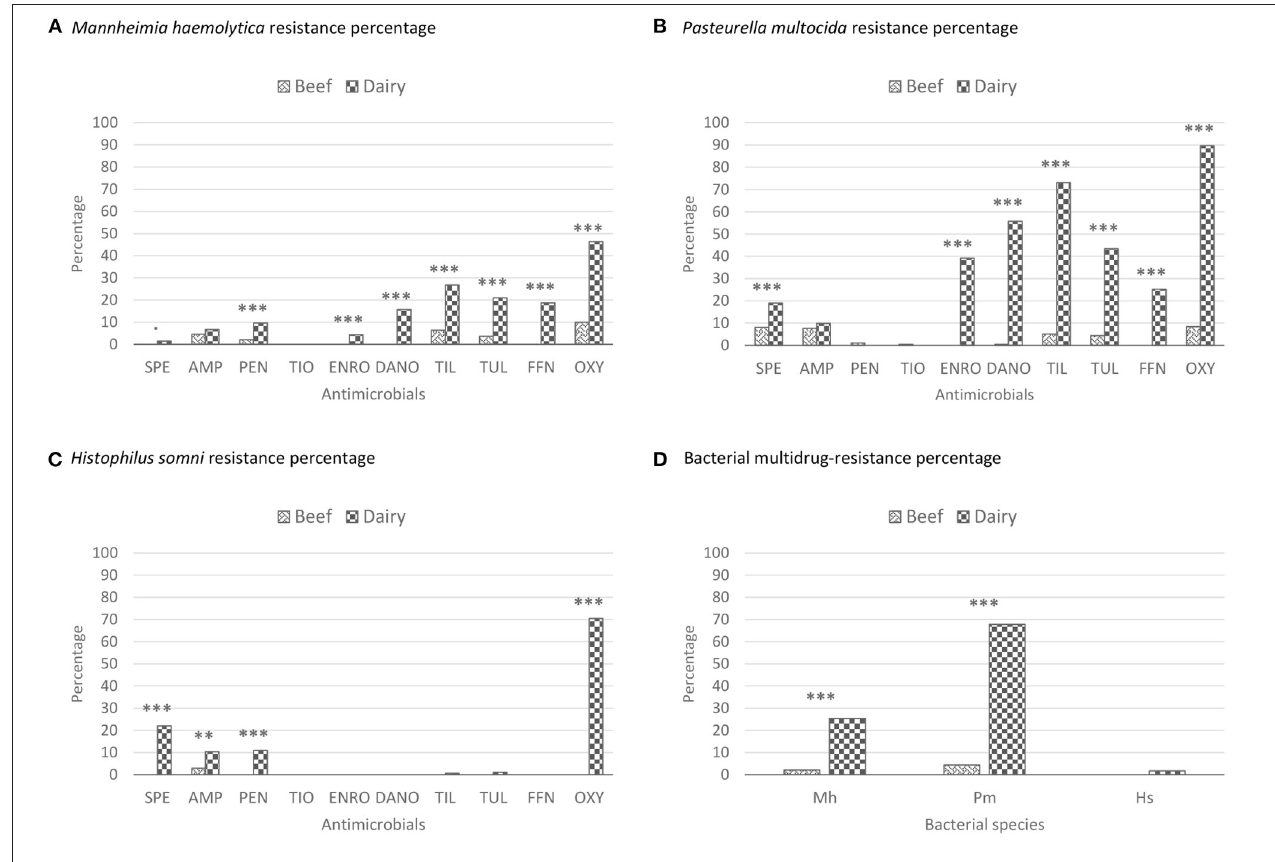
FIGURE 2 | Antimicrobial resistance percentages of the BRD-bacterial isolates recovered from beef and dairy-type cattle upon feedlot arrival. These percentages represent unadjusted proportions. The asterisks represent the statistical test significance levels as follows: “.” 0.1, “**” 0.01, “***” 0.001. Multidrug resistance was defined as resistance to 3 or more different antimicrobial classes ( 36). AMP, ampicillin; BRD, bovine respiratory disease; DANO, danofloxacin; ENRO, enrofloxacin; FFN, florfenicol; Hs, Histophilus somni ; Mb, Mycoplasma bovis ; Mh, Mannheimia haemolytica ; OXY, oxytetracycline; PEN, penicillin; Pm, Pasteurella multocida ; SPE, spectinomycin; TIL, tilmicosin; TIO, ceftiofur; TUL, tulathromycin. (A) Beef SPE resistance (R): 0/281; beef AMP-R: 13/281; beef PEN-R: 6/281; beef TIO-R: 0/281; beef ENRO-R: 0/281; beef DANO-R: 0/281; beef TIL-R: 18/281; beef TUL-R: 10/281; beef FFN-R: 0/281; beef OXY-R: 28/281; dairy SPE-R: 3/209; dairy